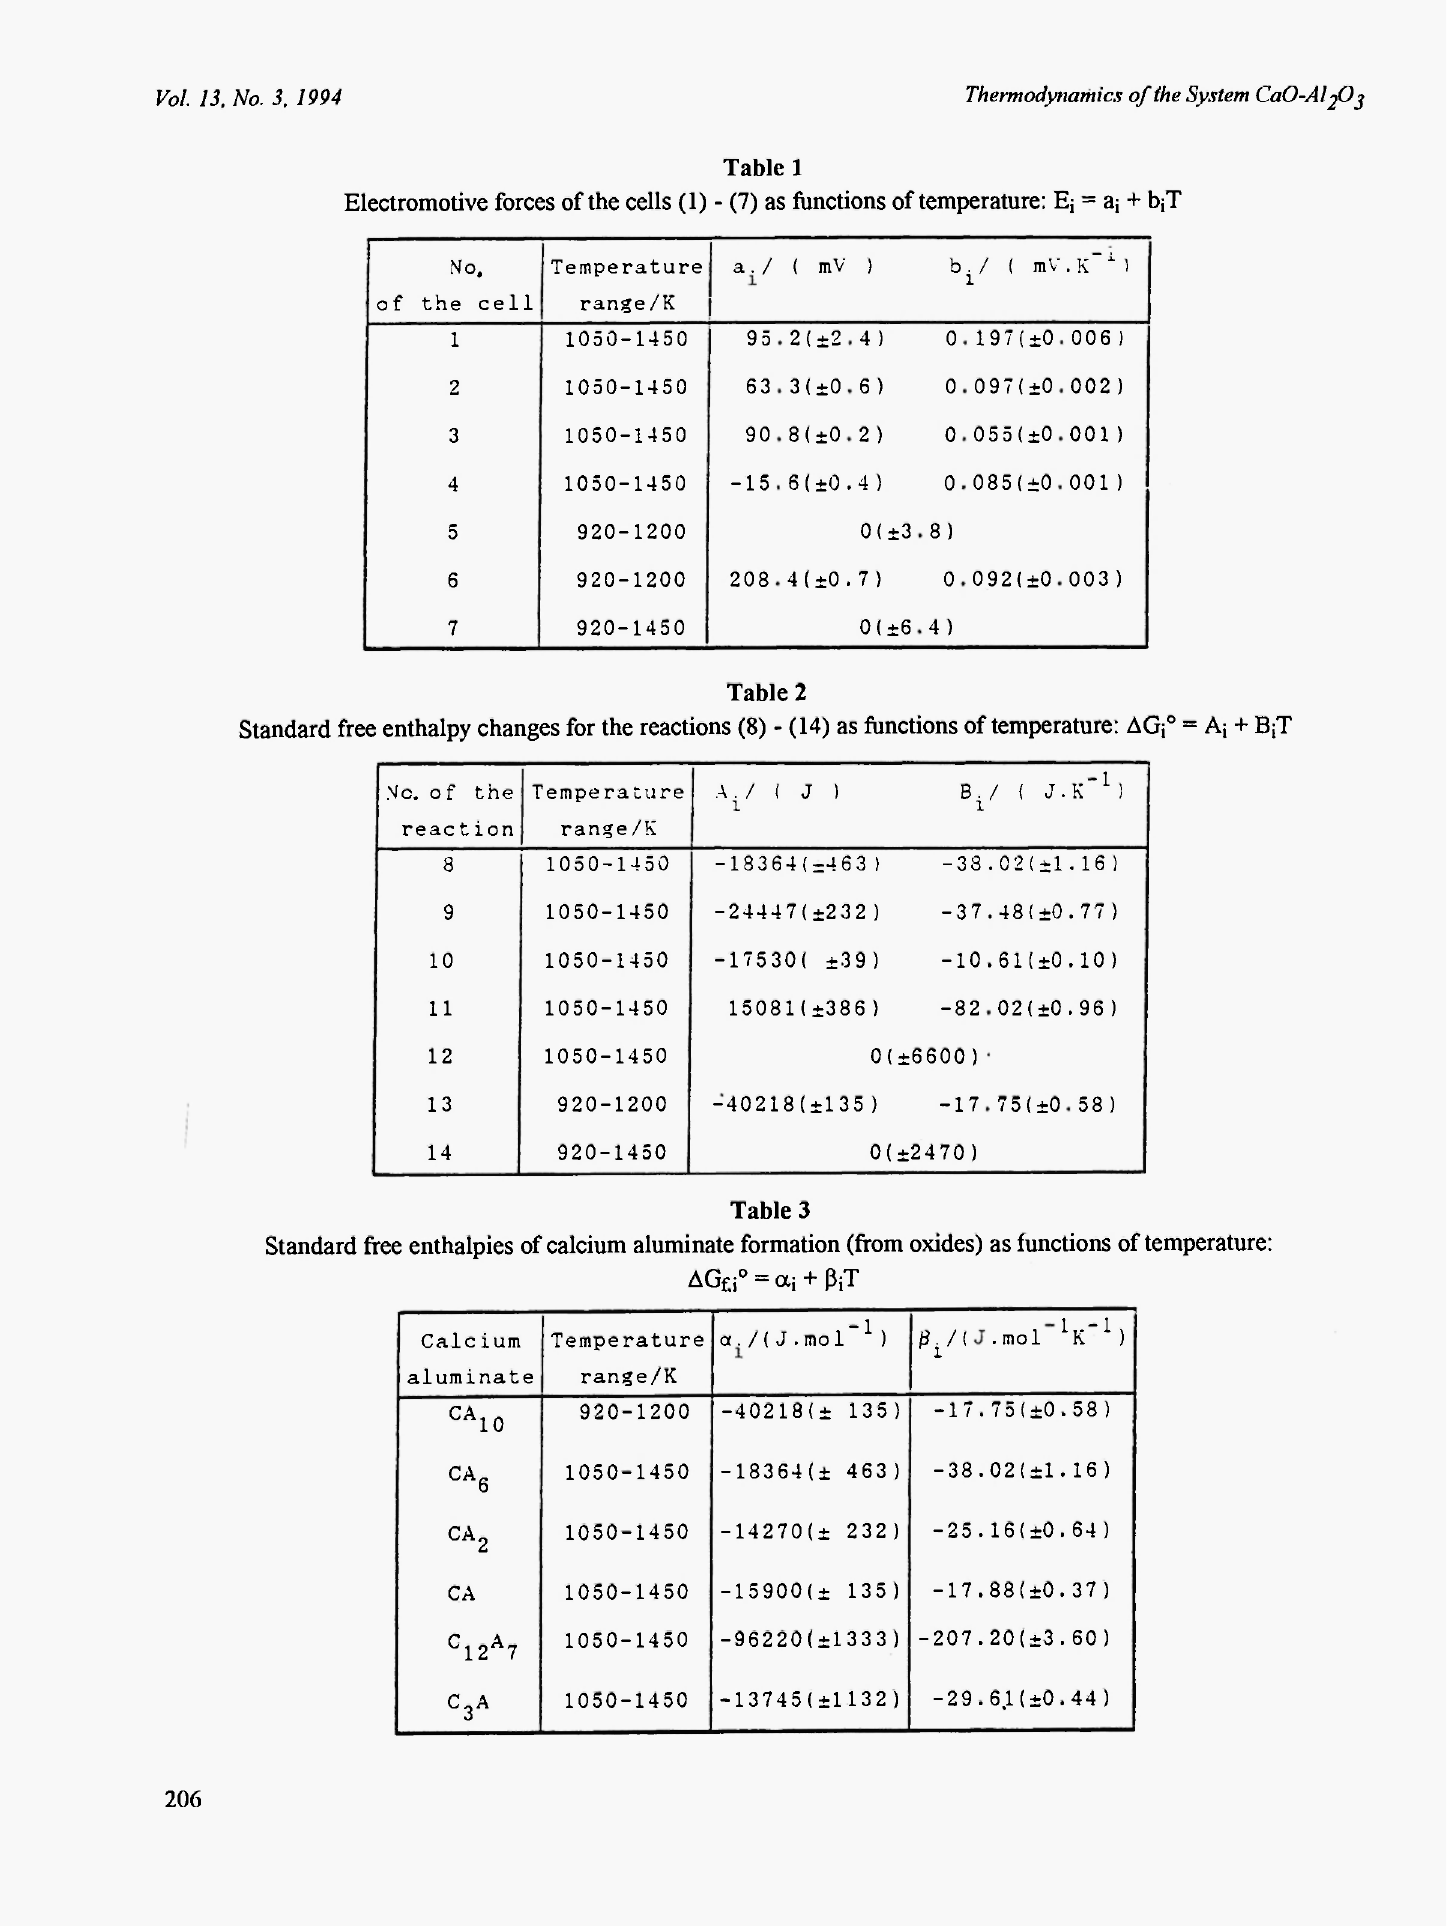
Electromotive forces of the cells (1) - (7) as functions of temperature: E; = a; + b;T